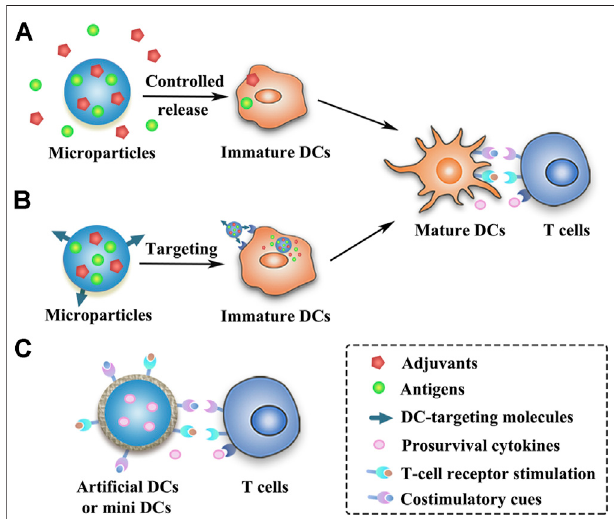
FIGURE 2 | Schematic presentation of strategies of different MP-based cancer vaccines. (A) Antigens and adjuvants are released in a controlled manner from the MPs and then taken up by the immature DCs. (B) DC- targeting MPs can release antigens and adjuvants within the DCs after being taken up by the immature DCs. (C) MP-based arti fi cial DCs or mini DCs can present T-cell activation signals to activate T cells or directly expand primary T